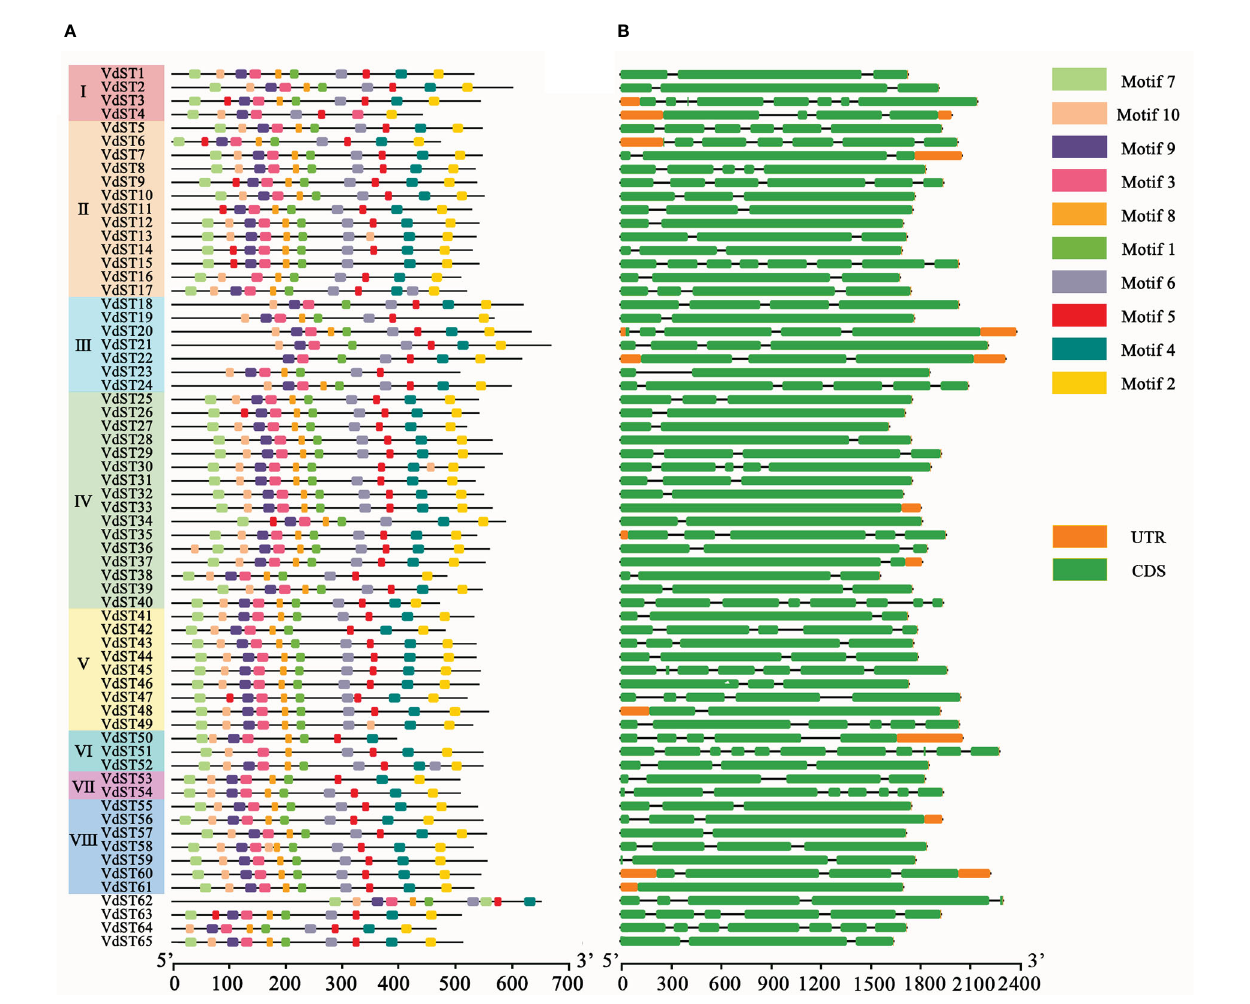
FIGURE 2 Conserved motifs and exon-intron structure of ST genes in V. dahliae . (A) Conserved motifs of the VdST proteins were identi fi ed by MEME program. Protein sequences and conserved motifs were represented by black lines and differently colored boxes, respectively. (B) Exon-intron structure of the 65 ST genes identi fi ed in V. dahliae . Untranslated regions, exons and introns were indicated by orange boxes, green boxes and black lines,